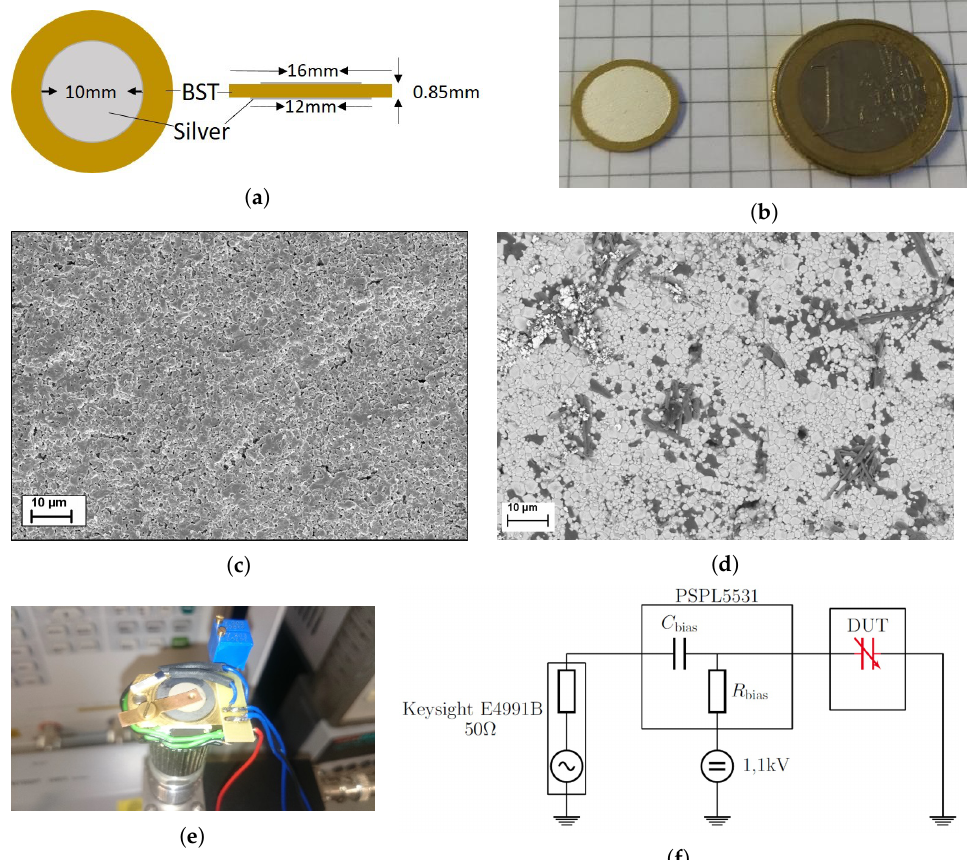
Figure 2. Manufactured varactor pellet with ( a ) schematic (top and side view) and ( b ) realized varactor. Microstructure analysis with scanning electron microscope images of ( c ) pure BST varactor ( d ) BST-MBO varactor. In the BST-MBO varactor, BST is shown by white color and MBO phases are shown by gray color. The measurement approach is shown with ( e ) pellet holder and ( f ) schematic circuit of the setup.